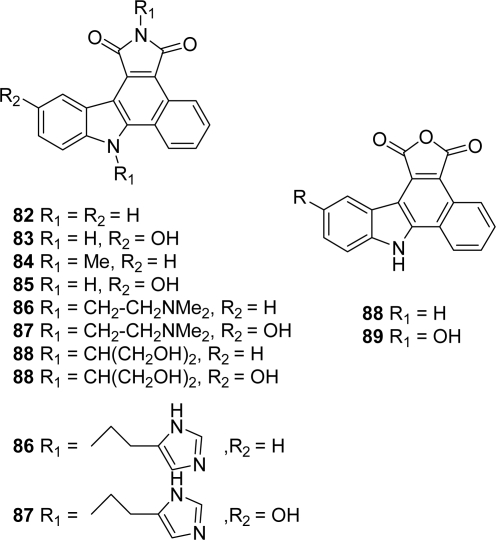
Phenylpyrrolocarbazoles proposed by Routier et al.